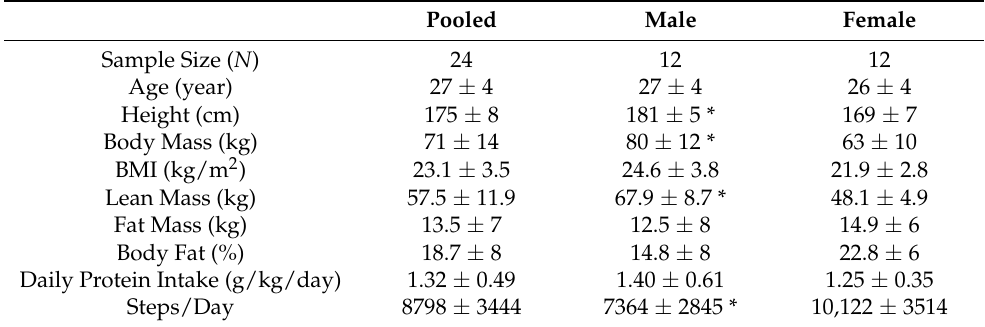
Table 1. Subject